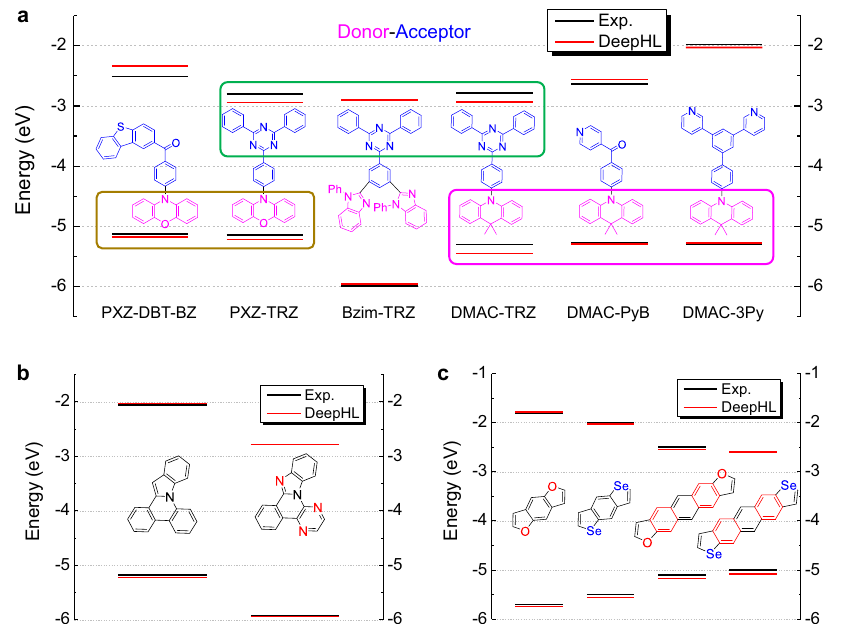
Fig. 4 Experimental and DeepHL-predicted HOMO and LUMO energies. a Donor – acceptor-type molecules. Identical moieties are grouped in the colored boxes. b The same core structure with a different number of nitrogen atoms. c Molecules with oxygen or selenium atoms and different conjugation